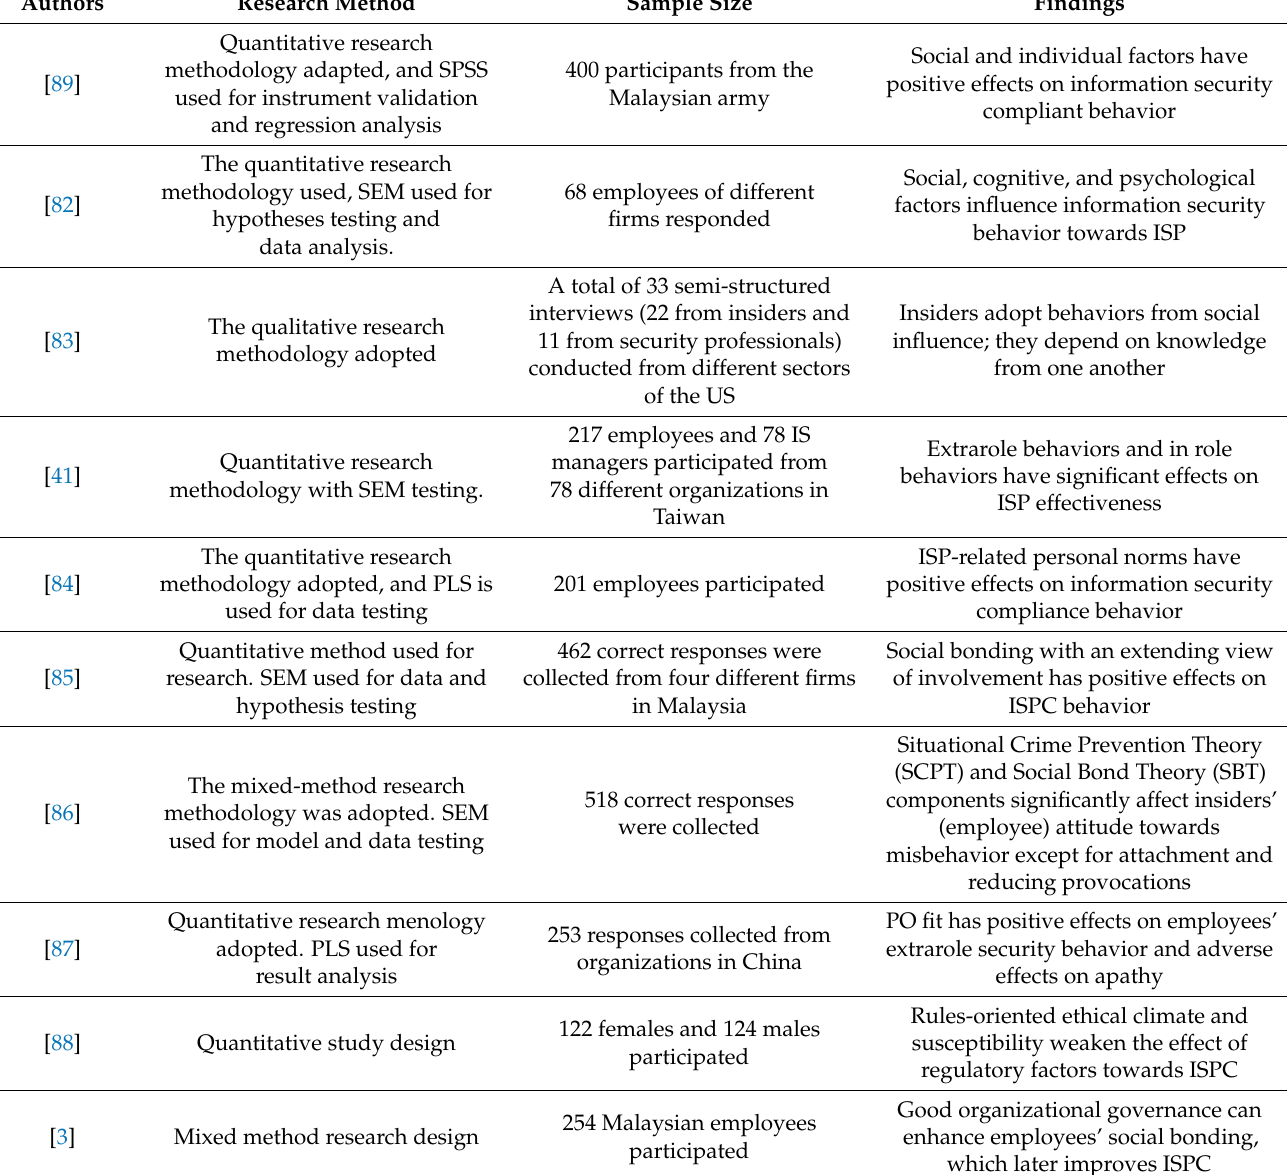
Table 9. Studies on social behaviors and